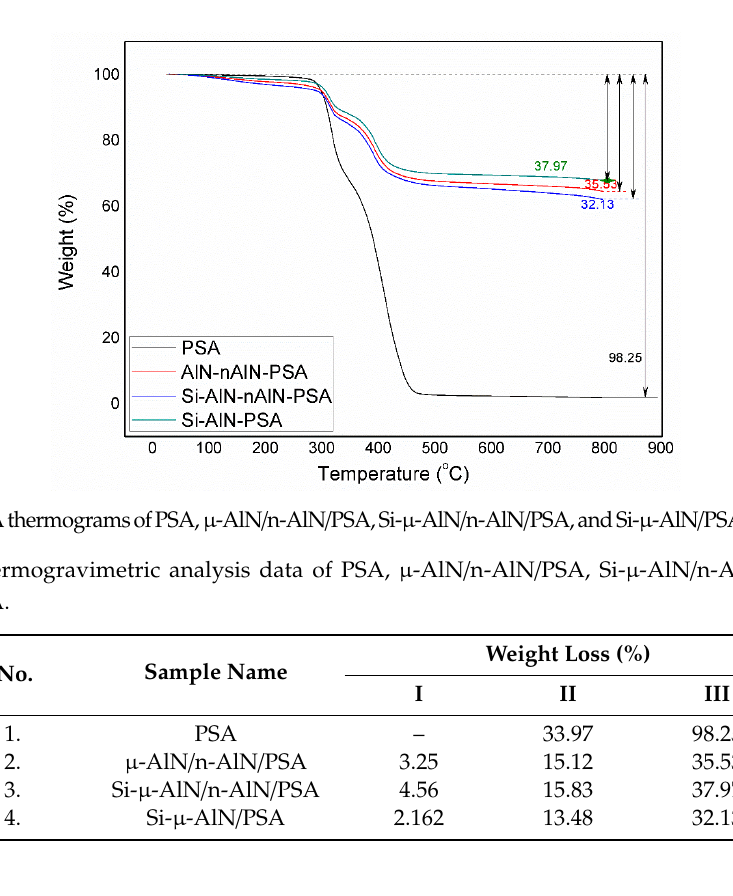
Table 3. Heat resistance index of PSA, µ -AlN / n-AlN / PSA, Si- µ -AlN / n-AlN / PSA, and Si- µ -AlN / PSA.